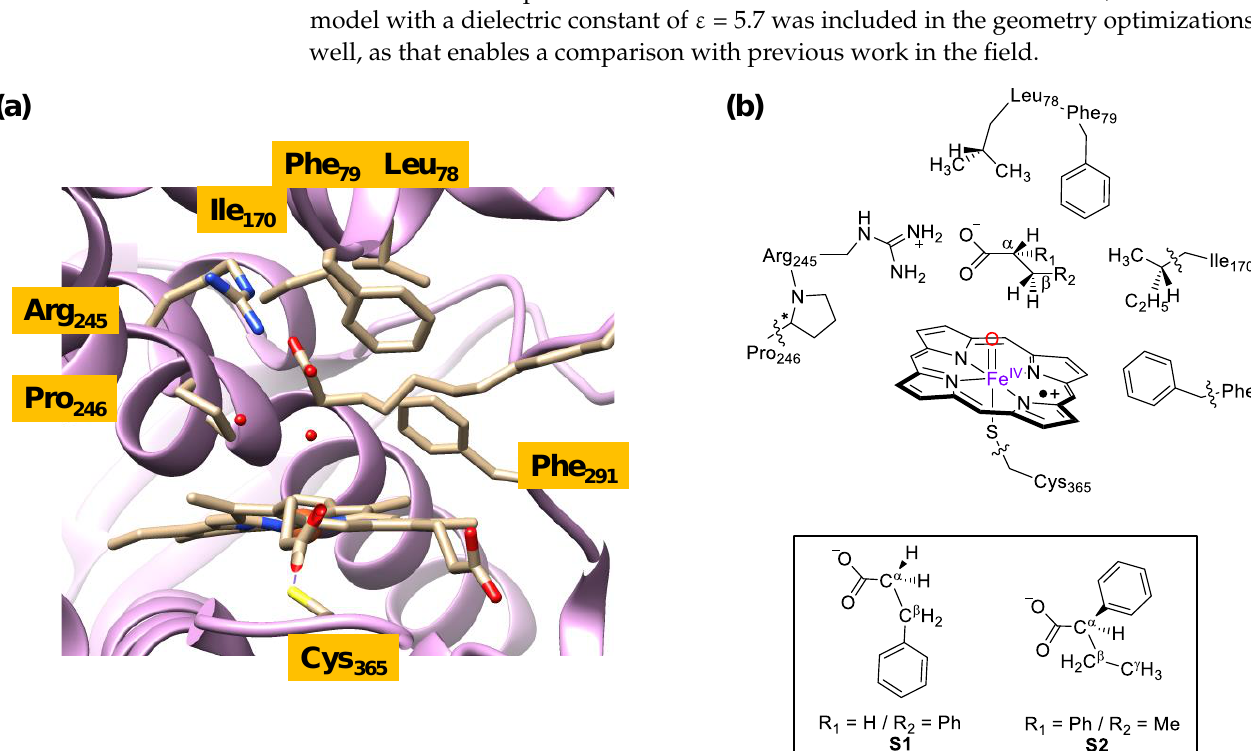
Figure 1. ( a ) Active site of the crystal structure coordinates of the substrate-bound form of P450 OleT JE from the 4L40 protein databank file with key residues highlighted; ( b ) cluster models of the active site of P450 OleT JE as investigated in this work with the substrates S1 and S2 shown in the